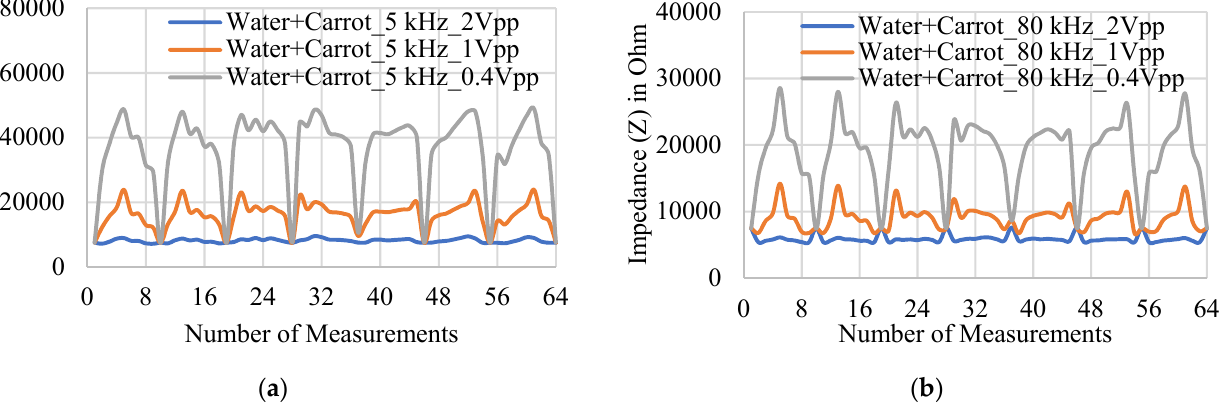
Figure 9. EIS measurements for an inhomogeneous media (water + carrot) in the domain consisting of eight electrodes by varying output excitation at ( a ) 5 kHz, and ( b ) 80 kHz, respectively.